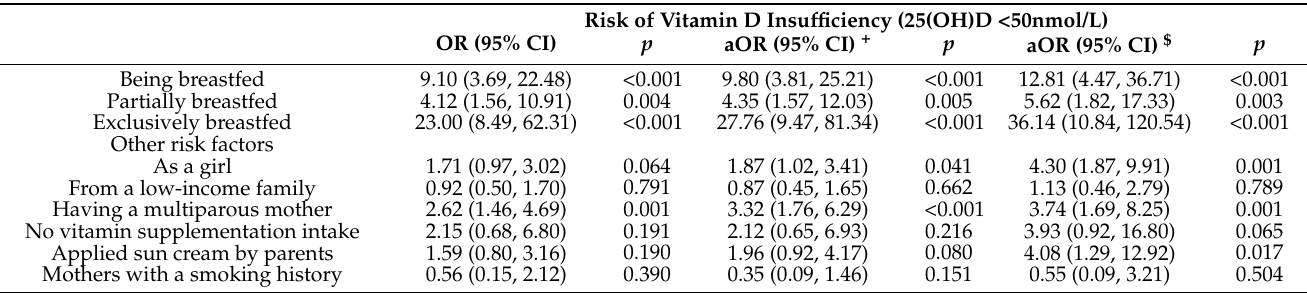
Table 2. Factors affecting vitamin D insufficiency or deficiency risk among infants aged 2 to 6 months.